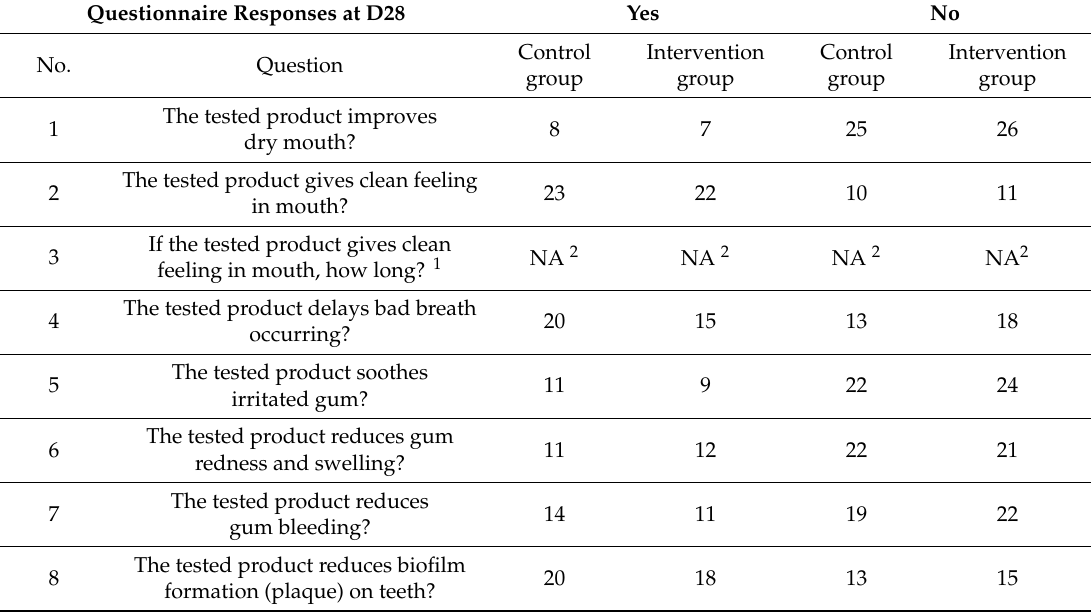
Table 4. Questionnaire responses about the test toothpaste and control toothpaste at the end of the study. Questionnaire Responses at